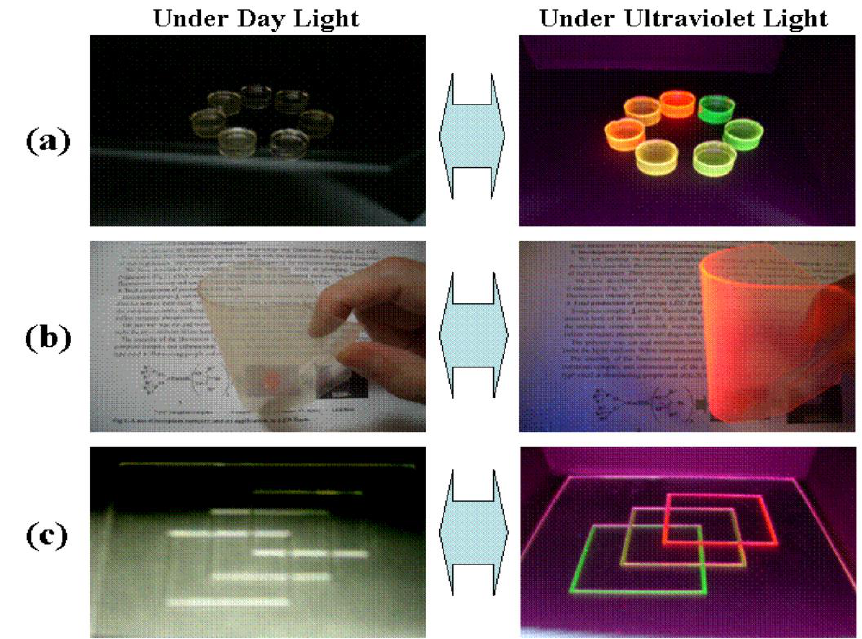
Figure 4. Colorless and transparent emission materials produced by dissolving Eu(III) complexes and/or Tb(III) complexes in a polymer. ( a ) block; ( b ) flexible sheet; ( c ) print on glass [43] .